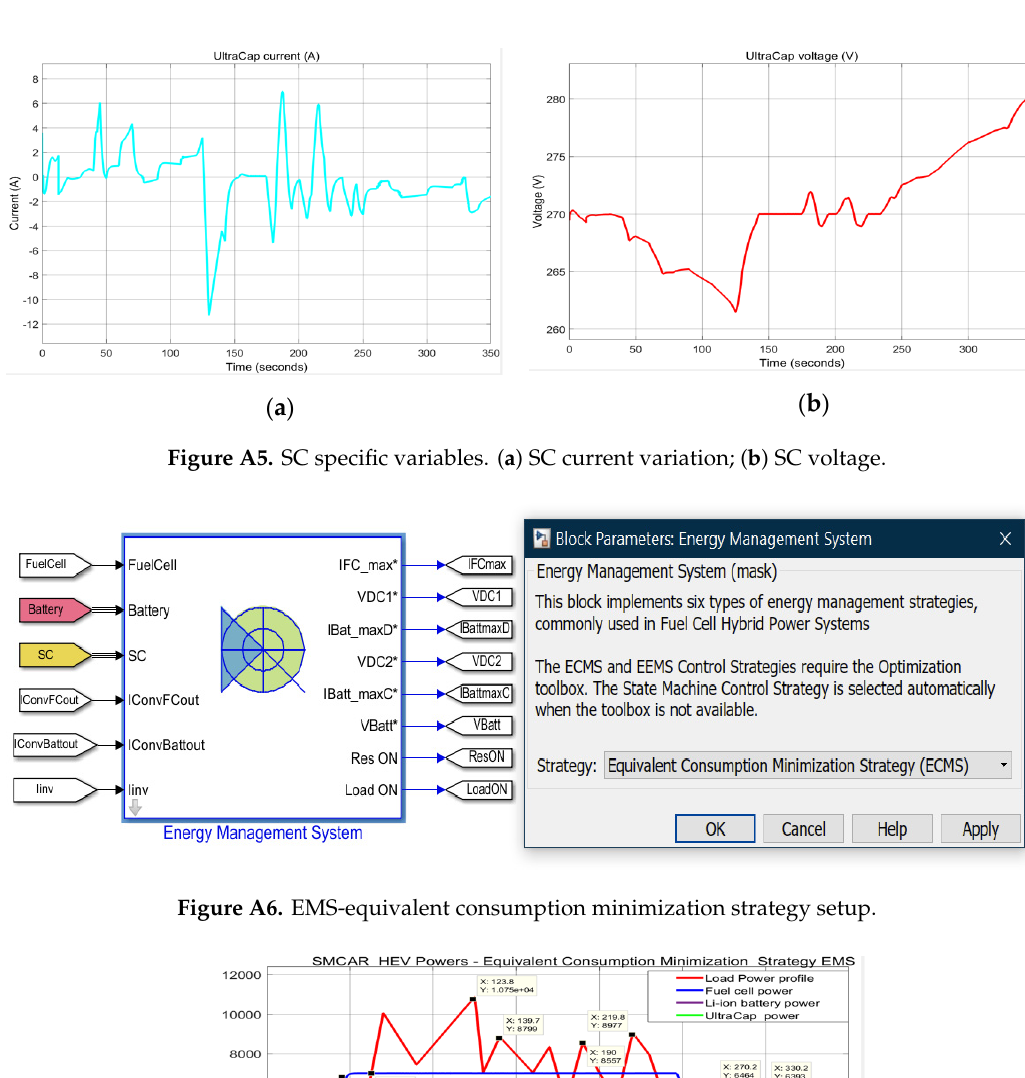
Figure A4. Li-ion battery specific variables. ( a ) Battery current; ( b ) battery voltage; ( c ) battery SOC.